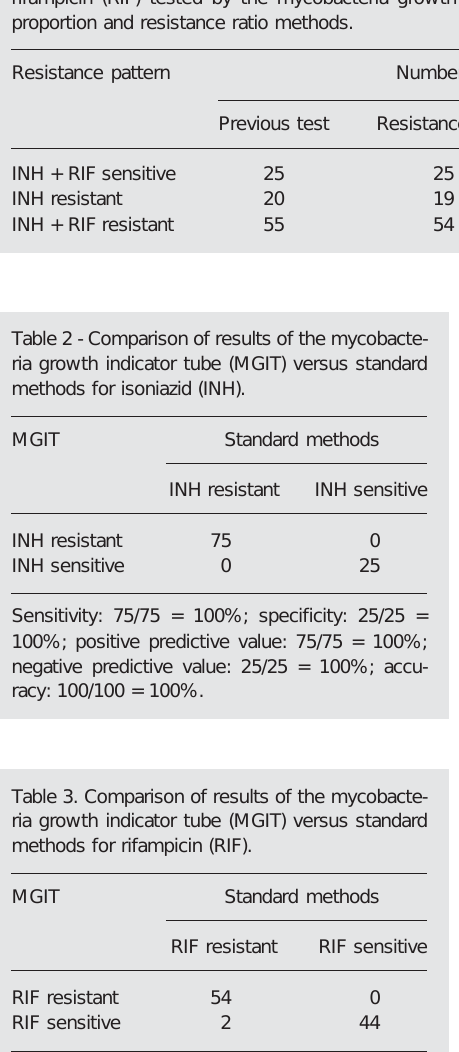
Table 1. Susceptibility of Mycobacterium tuberculosis strains to isoniazid (INH) and